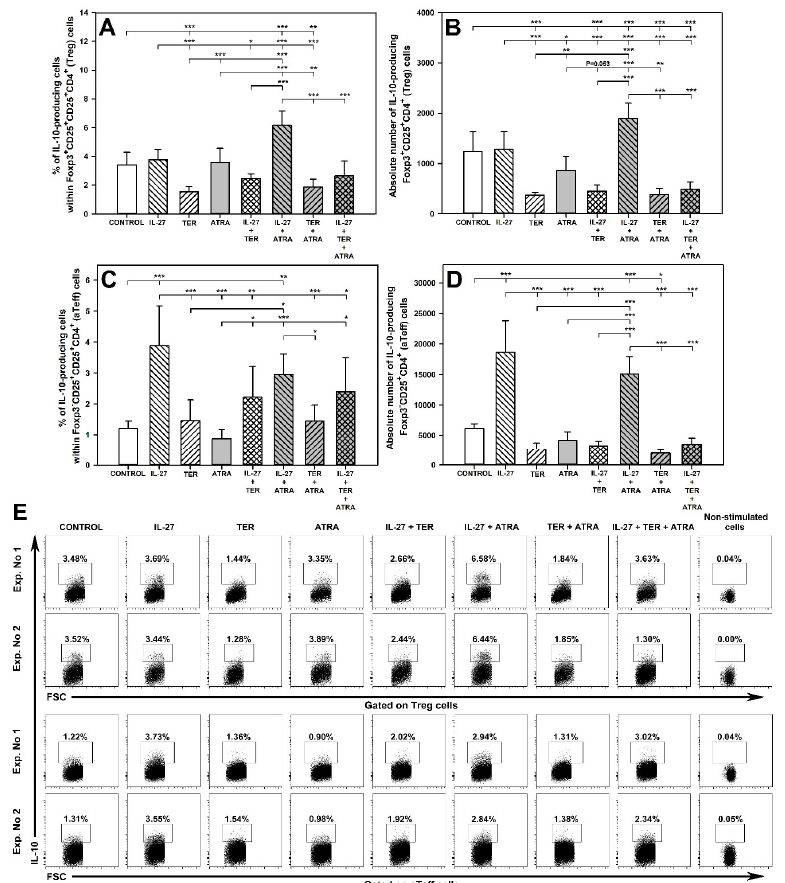
Figure 7. Effect of IL-27, teriflunomide (TER), all-trans-retinoic acid (ATRA), and their combinations on the number of IL-10-producing Foxp3 + CD25 + CD4 + and Foxp3 − CD25 + CD4 + T cells, i.e., regulatory (Treg) and activated effector (aTeff) T cells, respectively. The relative ( A , C ) and absolute count ( B , D ) of particular cell subsets were determined in cell cultures incubated in the absence (CONTROL) and presence of IL-27 (100 ng/mL), TER (10 −4 M), and ATRA (10 −6 M) for 72 h including concomitant stimulation with IL-2, anti-CD3, and anti-CD28 and re-stimulation with PMA and ionomycin for the last 5 h before harvest. Unstimulated cells served as a negative control for the cell activation. The relative count is expressed as a percentage of IL-10-producing cells within Foxp3 + CD25 + CD4 + ( A ) and Foxp3 − CD25 + CD4 + ( C ) T cell subsets. The absolute count represents the number of IL- 10 + Foxp3 + CD25 + CD4 + ( B ) and IL-10 + Foxp3 − CD25 + CD4 + ( D ) T cells per sample well. Results are ex- pressed as the mean (± S.D.) of two independent experiments with 4 mice per experiment (overall n = 8, * p < 0.05, ** p < 0.01, *** p < 0.001). Examples of dot plot cytograms showing the distribution of IL-10-producing cells within Foxp3 + CD25 + CD4 + ( E , upper panel) and Foxp3 − CD25 + CD4 + ( E , lower panel) T cell subsets.